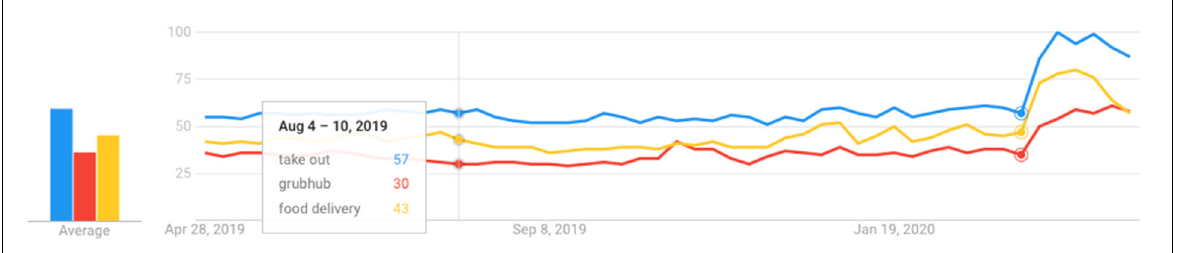
Source: Google Trends, April 27, 2020; circles to the right show week of March 8–14, 2020.